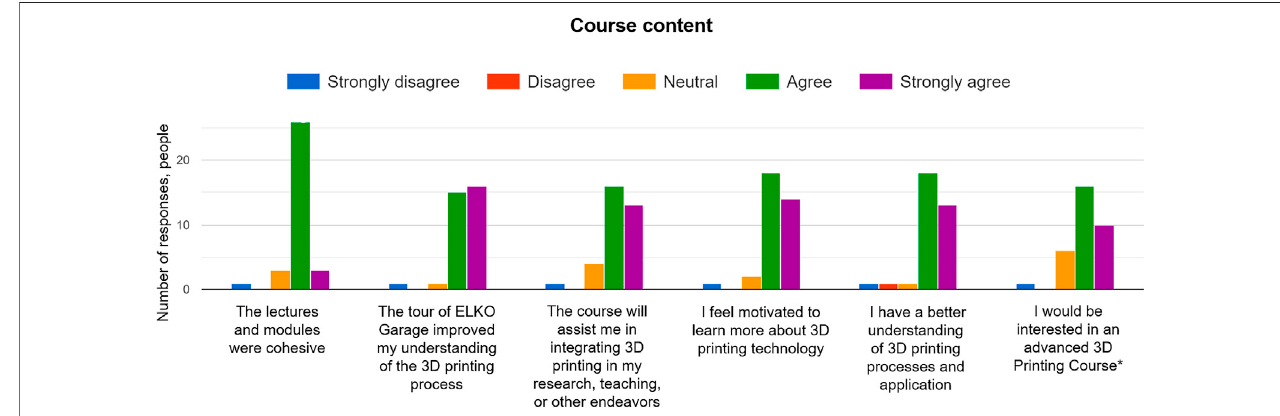
FIGURE7| Responsesofparticipantsforevaluationofthecoursecontent.Participantsassessedeachactivityattheendoftheshortcourse.*Aquestionaboutthe advanced 3D printing course is whether participants would like to have a short course on the applications of 3D printing in their respective discipline (not geoscience).